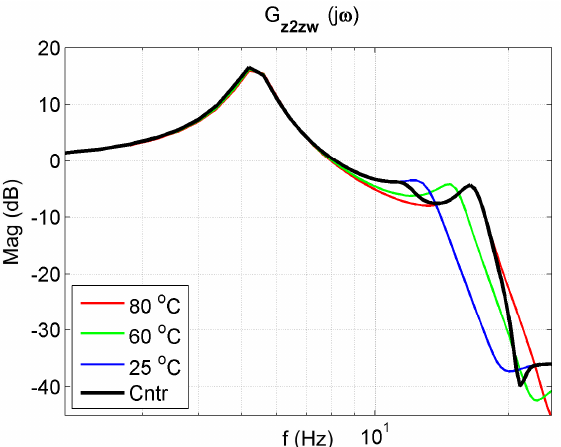
Figure 20. Vibration transmissibility functions of disturbance z w to the mass m 2 of the passive absorber for selected temperatures of 25 ◦ C, 60 ◦ C, 80 ◦ C and the controlled absorber (black). The transfer function G z 2 zw describes the